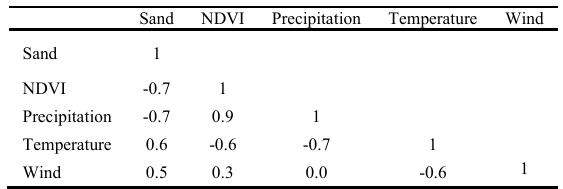
Table 5. Correlation